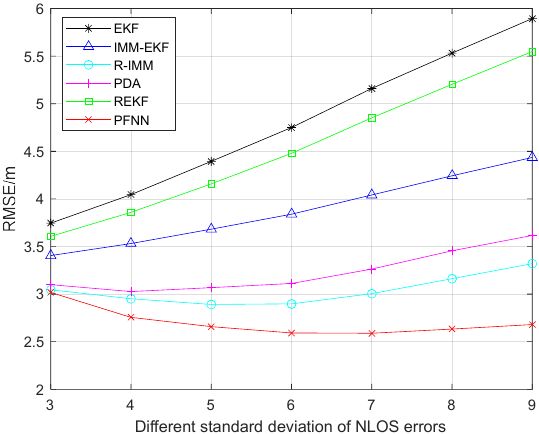
Figure 3. The RMSE versus the standard deviation of the NLOS error.